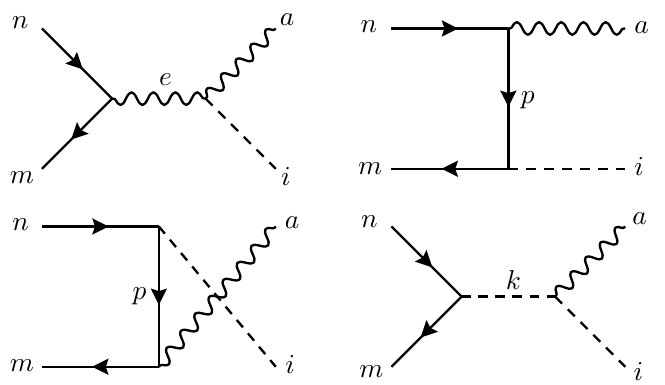
Figure 2 . Diagrams for the scattering f n + f